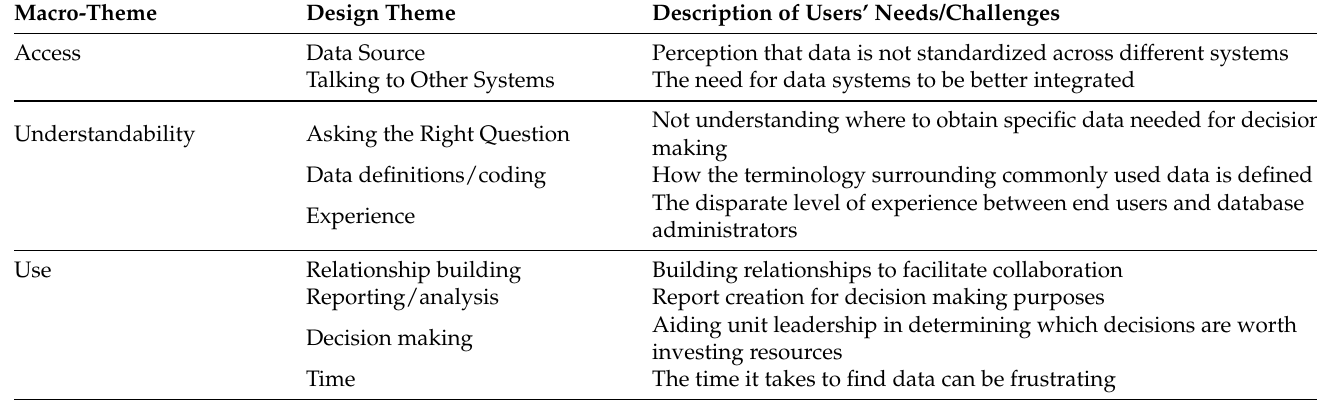
Table 1. Overview of the design themes that we identified as related with Access, Understandability, and